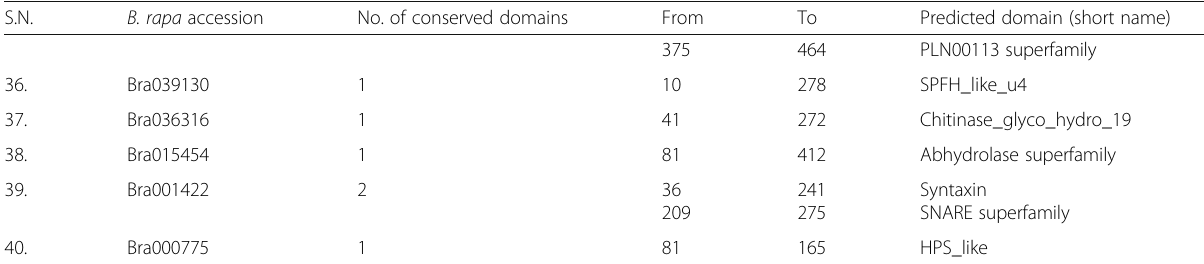
Table 4 Predicted conserved domains in identified upregulated Brassica rapa sequences with their positions under contrast SAMC (Continued)